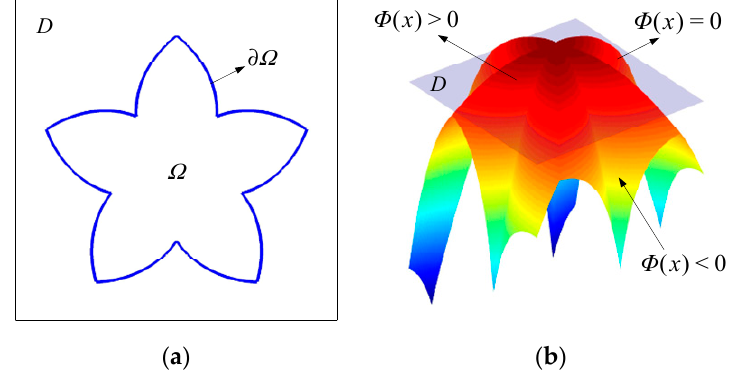
Figure 2. Illustration of the level-set function. ( a ) The physical domain is embedded to the computational domain ( b ) The level set function.